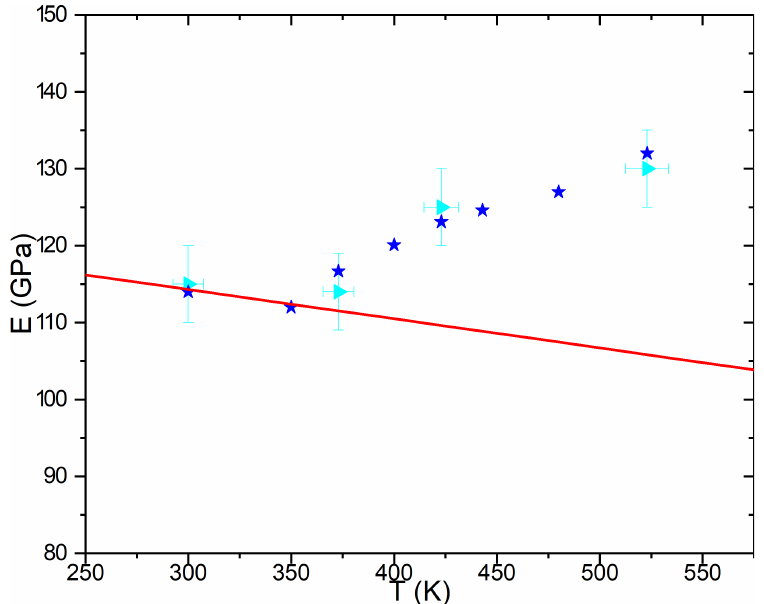
Figure 4. Comparison between experimental Young moduli (navy triangles) extracted from nano- indentation experiments performed on Ag 0.42 Cu 0.58 thin films and computed from application of the Phase Field approach including elastic terms (blue stars) versus the temperature. The red line is displays Young moduli resulting from a simple lever rule neglecting the formation of nano-structures under